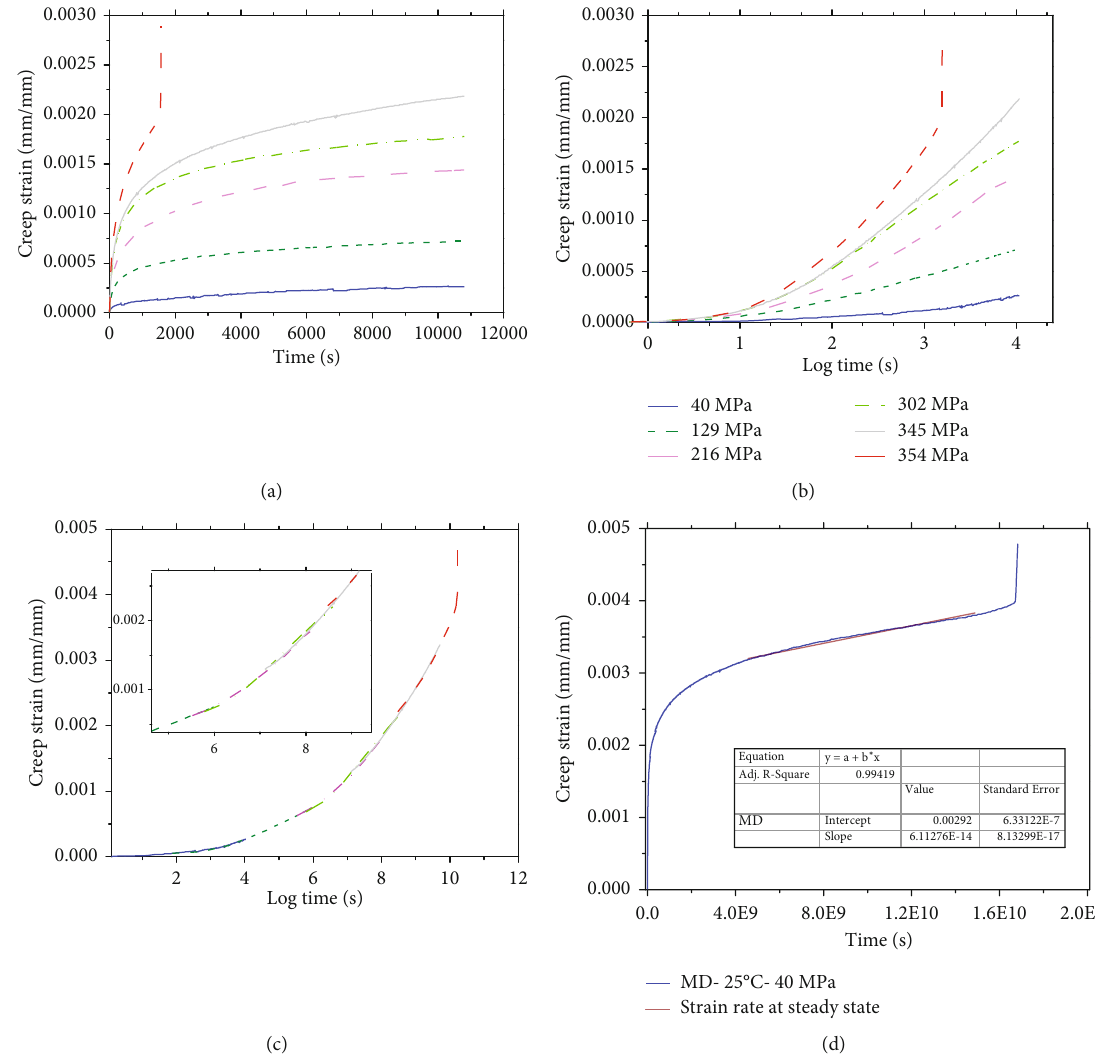
Figure 3: Sequences of generating master curve: (a) creep strain versus time, (b) creep strain versus logarithm of time, (c) shifted creep curves, and (d) master curve for the MD composite at 25 ° C and